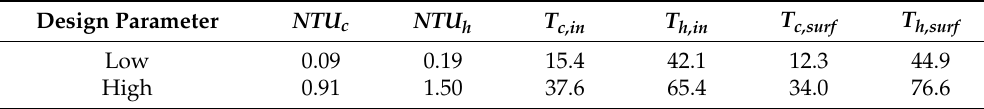
Table 6. The valid range of the proposed